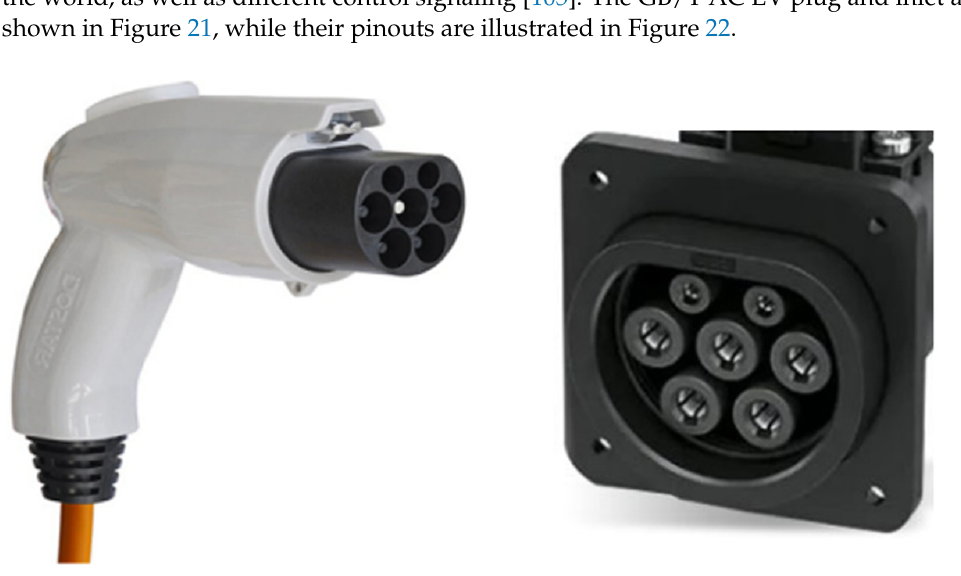
Figure 22. The GB/T AC Coupler pinout: EV Plug ( Left ) and Inlet ( Right ).